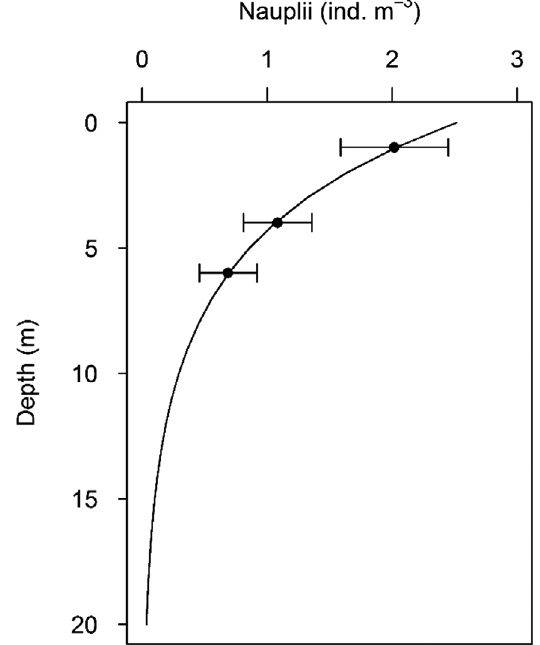
Fig. 5. Depth distribution of salmon lice nauplii in the fish cage (average ± SE, n = 9 at 1 m and n = 8 at 4 and 6 m depth). The line shows the fitted exponential decrease in nauplii abundance ( Y) with depth ( z ) down to the bottom of the cage: Y = 2.5e −0.215 z (R 2 = 0.9994, p < 0.05)